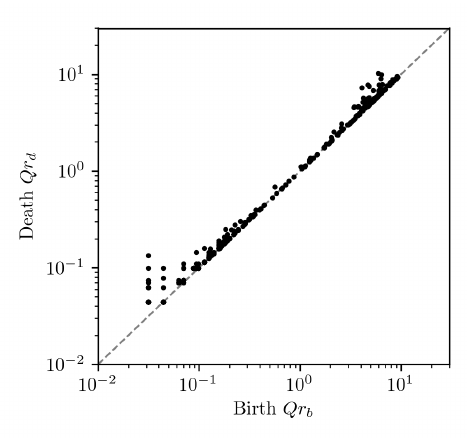
Figure 5: Persistence diagram of one-dimensional homology classes for the sequence of alpha complexes partially displayed in Fig. 4, Dgm